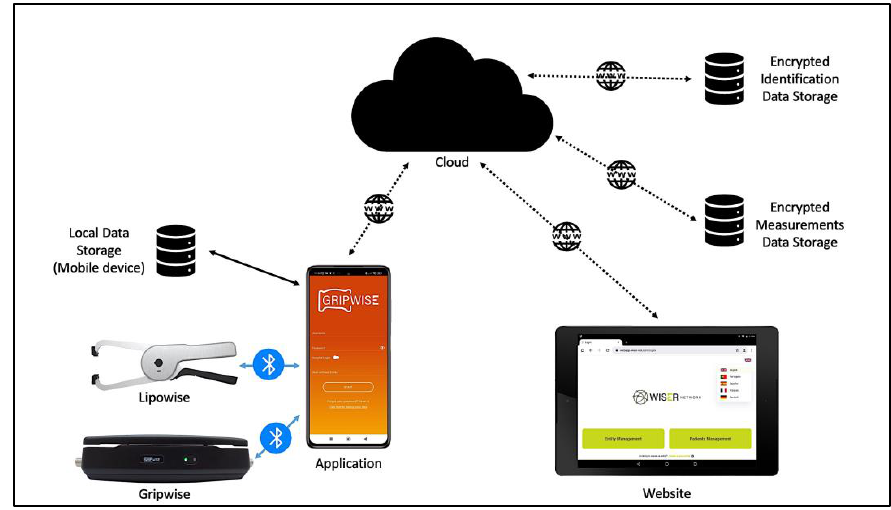
Figure 1. System Architecture. Lipowise and Gripwise devices (commercially available at https: